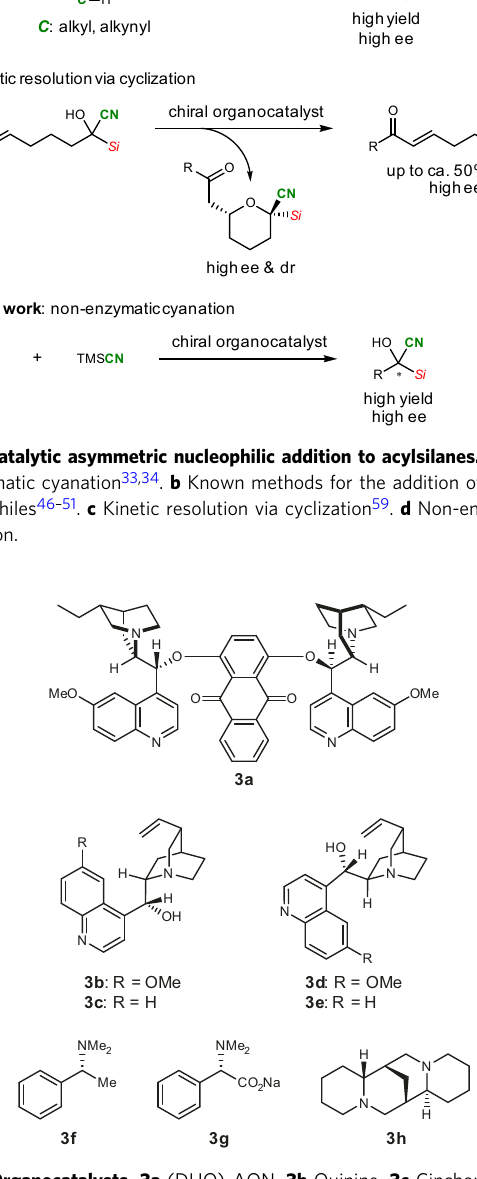
Fig. 2 Organocatalysts. 3a (DHQ) 2 AQN. 3b Quinine. 3c Cinchonidine. 3d Quinidine. 3e Cinchonine. 3f ( R )- N , N